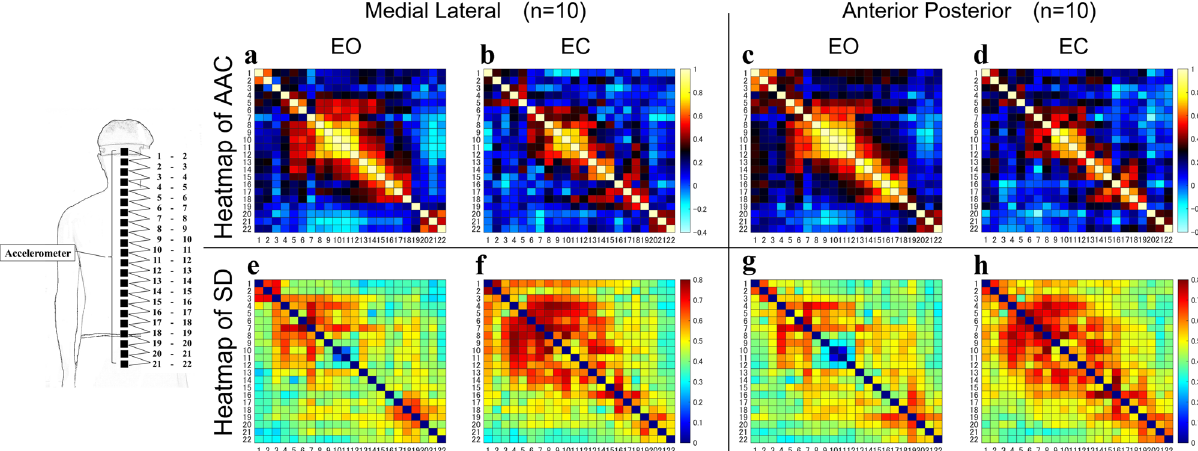
Figure 2. Mean and standard deviation of the similarity of acceleration between each sensor. The heatmaps of AAC ( a–d ) and SD ( e–h ) are shown for each condition (EO and EC). In the heat map of AAC, the left vertical and horizontal axes are the sensor numbers and the right vertical axis is the similarity. In the heat map of SD, the left vertical and horizontal axes are the sensor numbers and the right vertical axis is the standard deviation value. AAC: average acceleration correlation, SD: standard deviation, ML: medial–lateral direction, AP: anterior–posterior direction, EO: eye-opening condition, EC: eye-closing